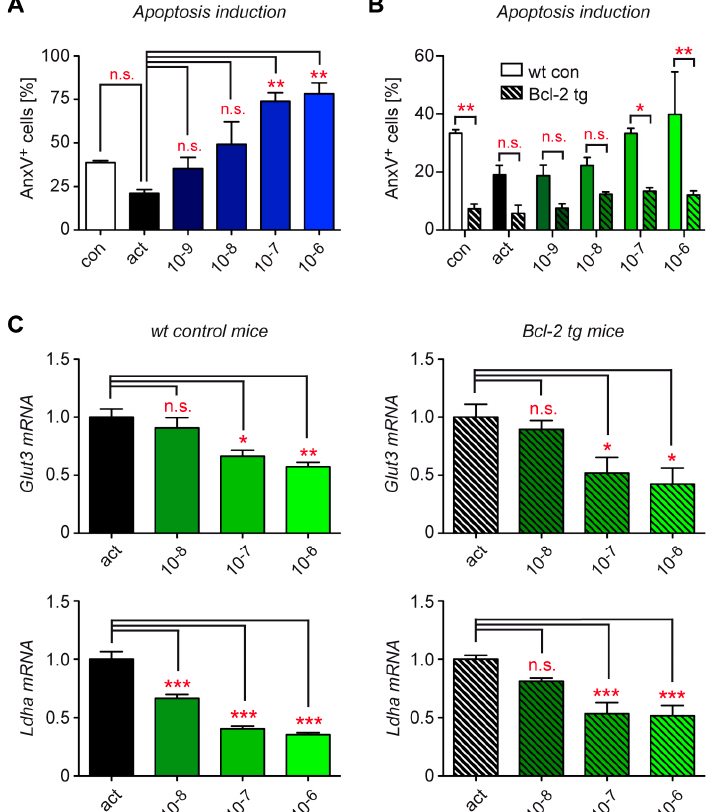
Figure 2. Role of apoptosis induction for the metabolic control of murine T cells by Dex in vitro. ( A ) T cells were purified from spleen and lymph nodes of C57BL/6 wild-type mice and stimulated with mCD3 ε and mCD28 antibodies for 24 h in the absence (act) or presence of 10 − 9 to 10 − 6 M Dex. T cells without stimulation served as a control (con). Apoptosis induction was determined by flow cytometric analysis of AnxV + cells amongst CD3 + CD4 + T cells. N = 4. ( B ) T cells were purified from wild-type (wt), control (con), or Bcl-2 tg mice. Treatment and analysis were performed as in panel A. N = 3. ( C ) T cells were obtained from wt, control, or Bcl-2 tg mice and treated as in panels A/B. Gene expression was determined by RT-qPCR. N = 5. Relative mRNA levels were calculated by normalization to the housekeeping gene Hprt . Expression in activated T cells was arbitrarily set to 1. Values are depicted as the mean ± SEM. Statistical analysis was performed by one-way ANOVA followed by a multiple comparisons test. Levels of significance: * p < 0.05; ** p < 0.01; *** p < 0.001; n.s.: p >